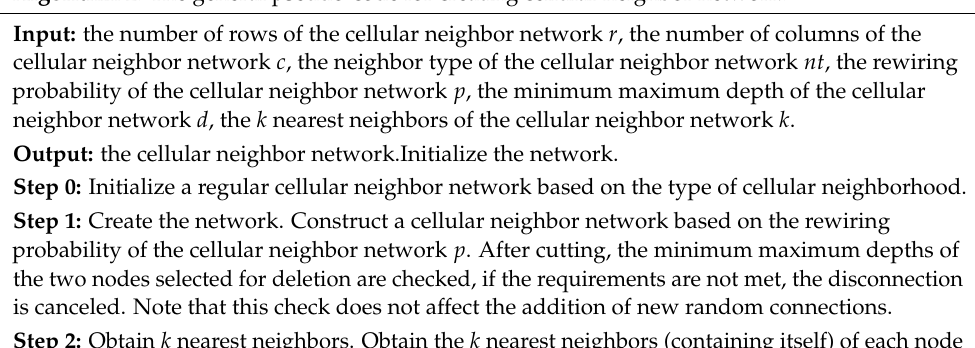
Algorithm 2 . The general pseudo-code for creating cellular neighbor